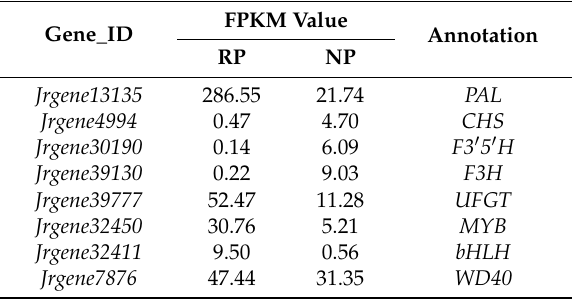
Table 5. Expression profiles of anthocyanin biosynthesis genes in walnut peel.